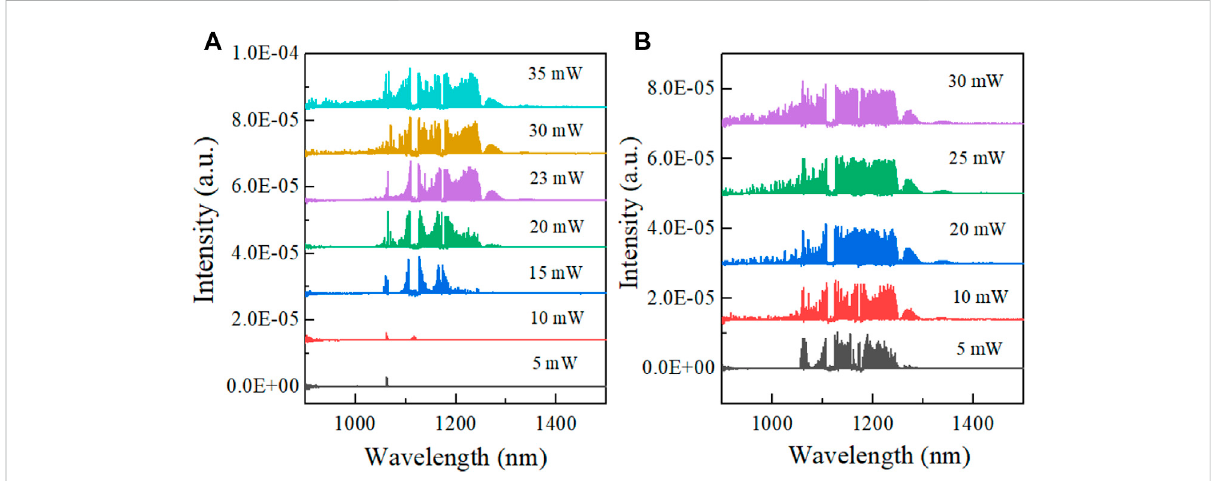
FIGURE 6 (Coloronline)Outputspectraobtainedfromthe (A) 30-mGRIN-MMFwith40%couplingef fi ciencyand (B) 10-mGRIN-MMFwith60%coupling ef fi ciency at different average